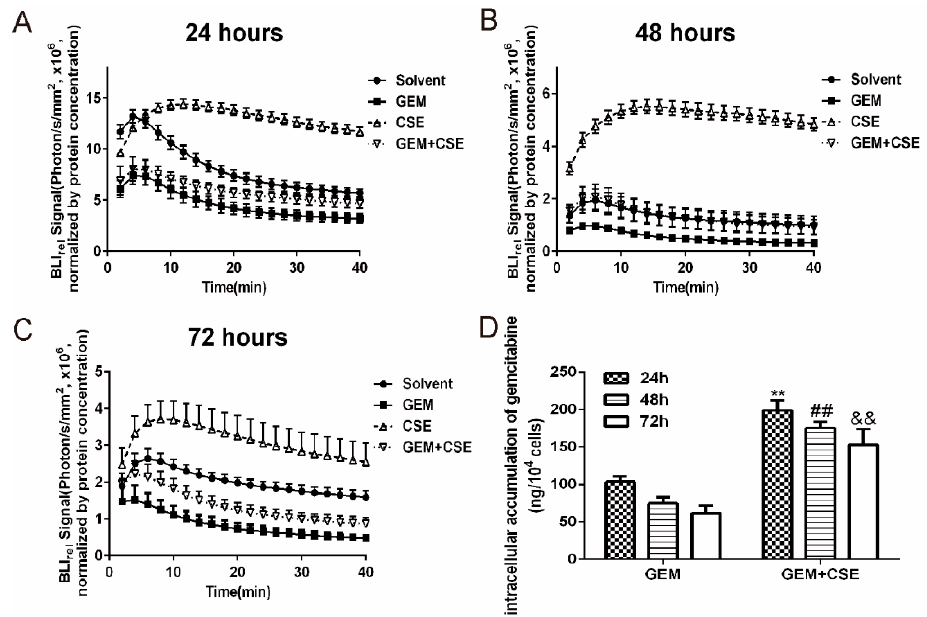
Figure 2. Relative bioluminescence imaging (BLI rel ) signal-time curves of D-luciferin and intracellular accumulation of gemcitabine in BxPC3 luc cells. Cells were first exposed